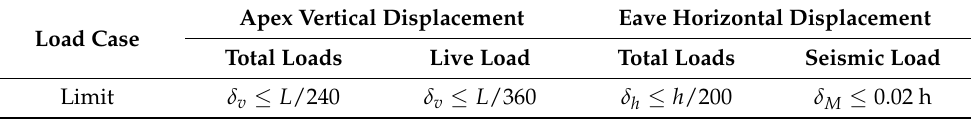
Table 3. Serviceability